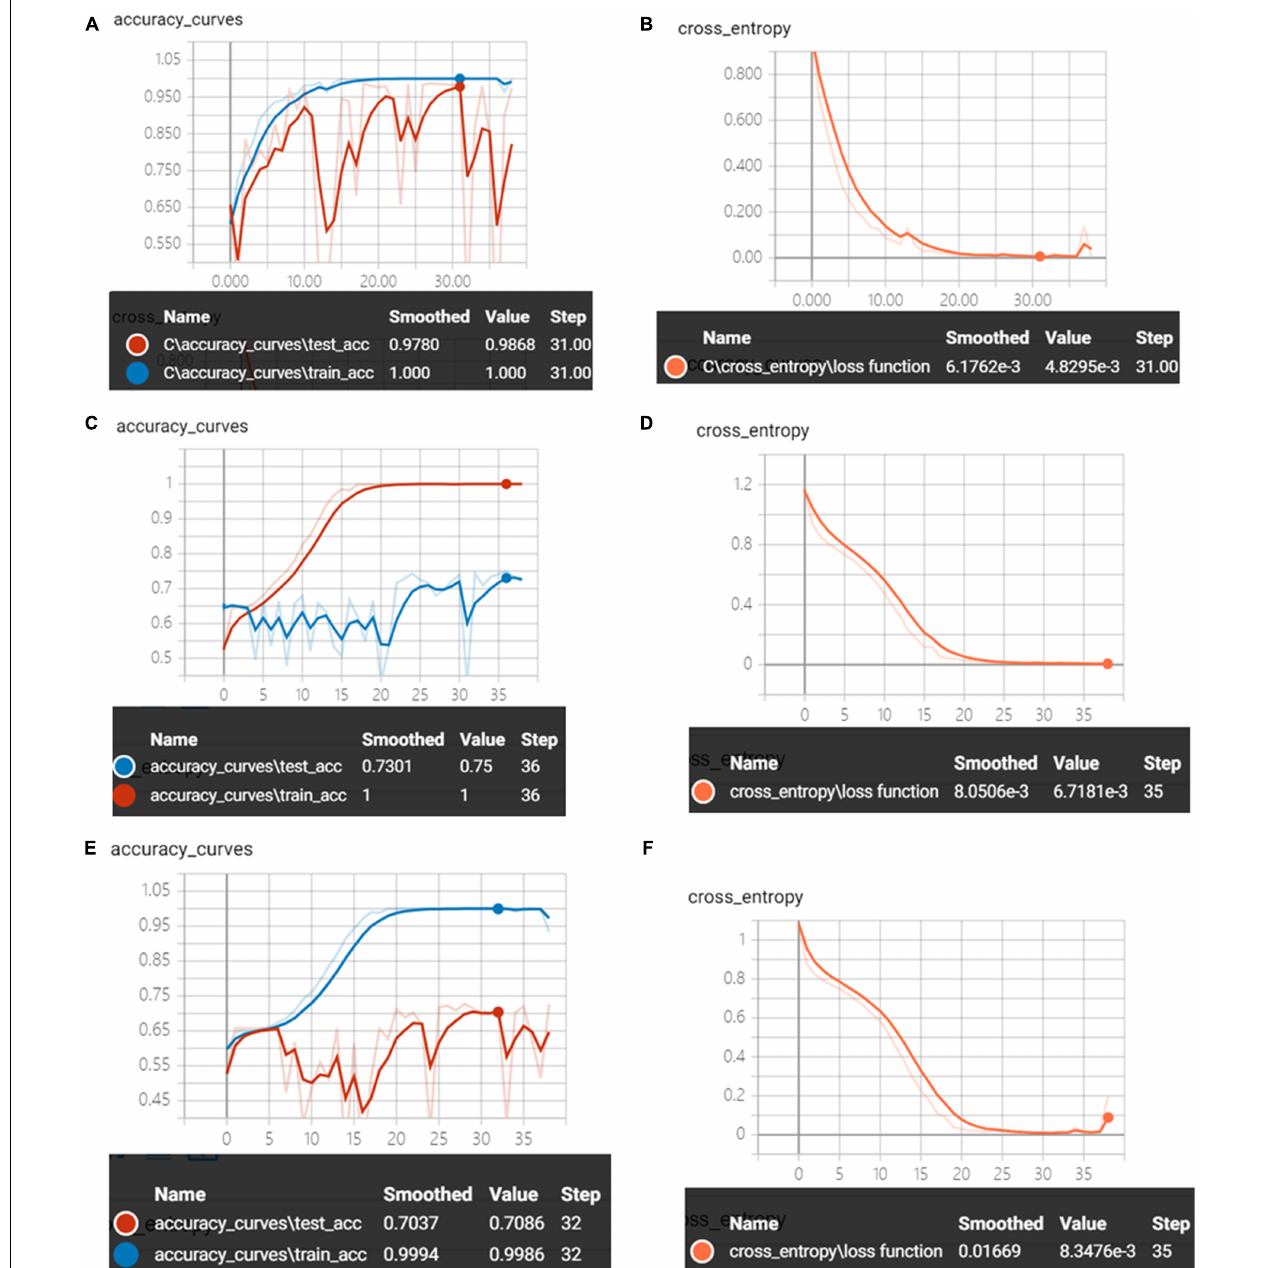
FIGURE 12 | (A) The accuracy curves of synchronous 2DCOS spectra on the 1,150–1,000-cm − 1 band. (B) The cross-entropy cost function of synchronous 2DCOS spectra on the 1,150–1,000-cm − 1 band. (C) The accuracy curves of asynchronous 2DCOS spectra on the 1,150–1,000-cm − 1 band. (D) The cross-entropy cost function of asynchronous 2DCOS spectra on the 1,150–1,000-cm − 1 band. (E) The accuracy curves of i2DCOS spectra on the 1,150–1,000-cm − 1 band. (F) The cross-entropy cost function of i2DCOS spectra on the 1,150–1,000-cm − 1 band.